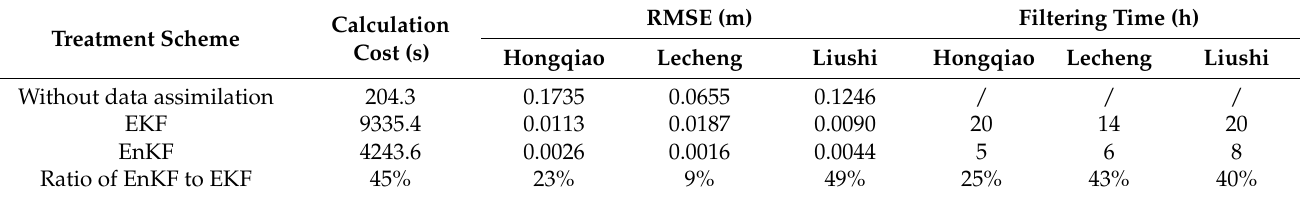
Table 8. Comparison of evaluation metric results for EKF and EnKF in Case